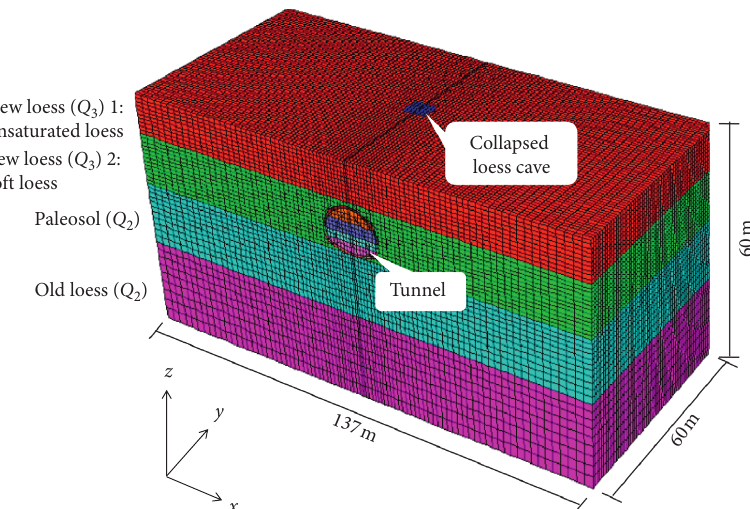
Figure 20: Computation model A.